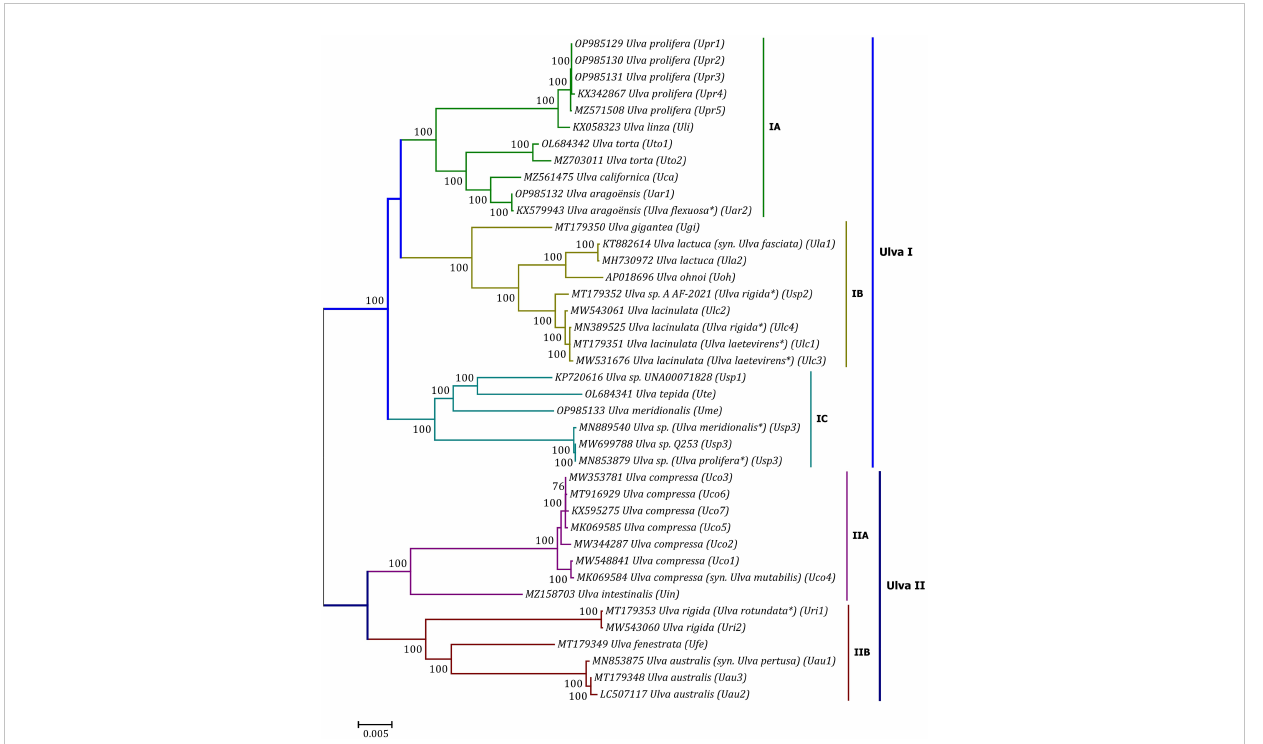
FIGURE 10 Unrooted phylogenomic tree based on Maximum Likelihood (ML) analysis of the nucleotide (nt) sequences of the 100 common genes in the 40 Ulva plastomes. The bootstrap support values greater than 70% were displayed at branches. Branch lengths are proportional to the amount of sequence change, which are indicated by the scale bar below the trees. The asterisk indicates that the species name has been corrected.